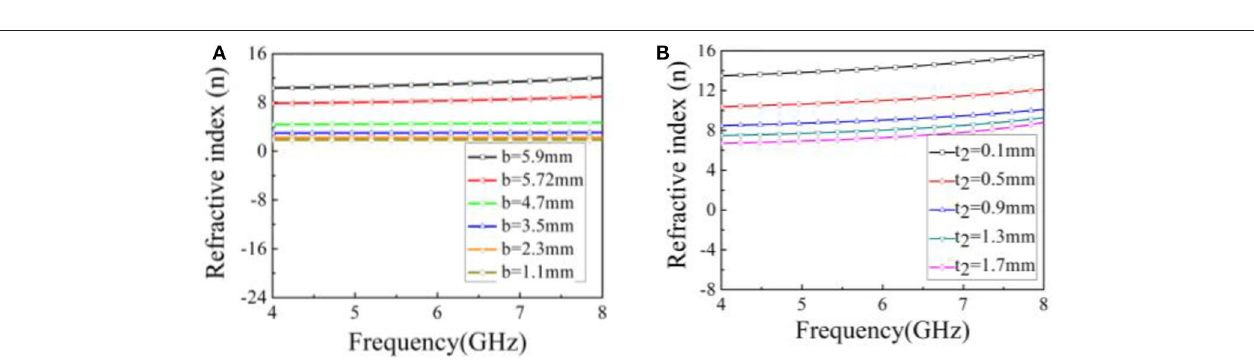
FIGURE 2 | (A) Influence of the size of metal patch on the refractive index of HRIM. (B) Effect of the dielectric thickness t 2 on the refractive index of HRIM.